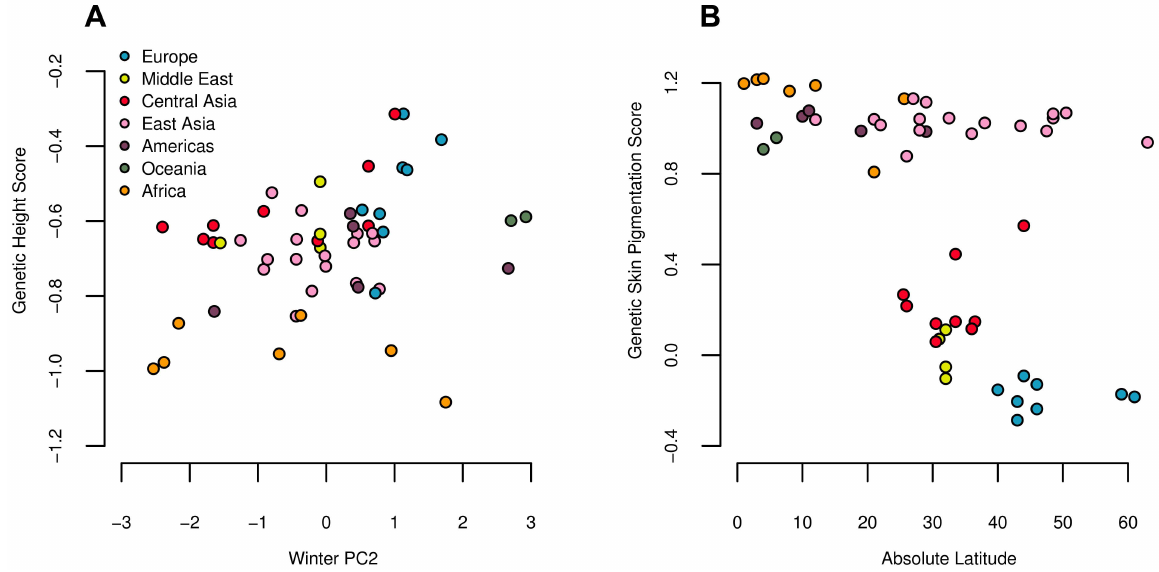
Figure 6. Estimated genetic height (A) and skin pigmentation score (B) plotted against winter PC2 and absolute latitude respectively. Both correlations are significant against the genome wide background after controlling for population structure (Table 2).